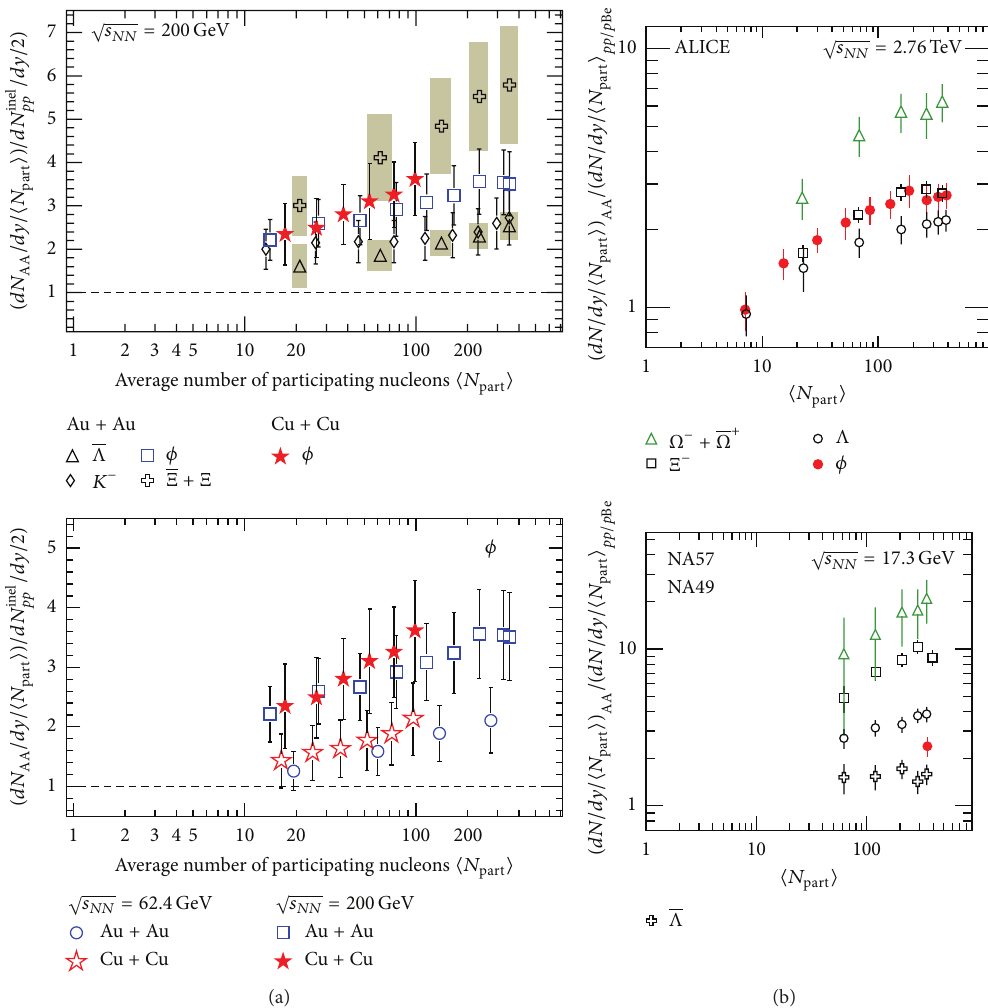
⟩ nucleus-nucleus collisions and to corresponding yields Figure 4: (a) The ratio of the yields of 𝐾 − , 𝜙 , Λ , and Ξ + Ξ normalised to ⟨𝑁 part ⟩ at 62.4 and 200 GeV [24]. Error bars are quadrature sum of statistical and systematic in proton-proton collisions as a function of ⟨𝑁 part ⟩ normalised yield of 𝜙 , Λ , Λ , Ξ − , and Ω − + Ω + in Pb + Pb collisions to the corresponding yield in 𝑝 + 𝑝 uncertainties. (b) The ratio of ⟨𝑁 part ( 𝑝 + Be) collisions at 17.3 GeV (NA57 & NA49) [25, 26] and 2.76 TeV (ALICE) [21]. Only statistical uncertainties are